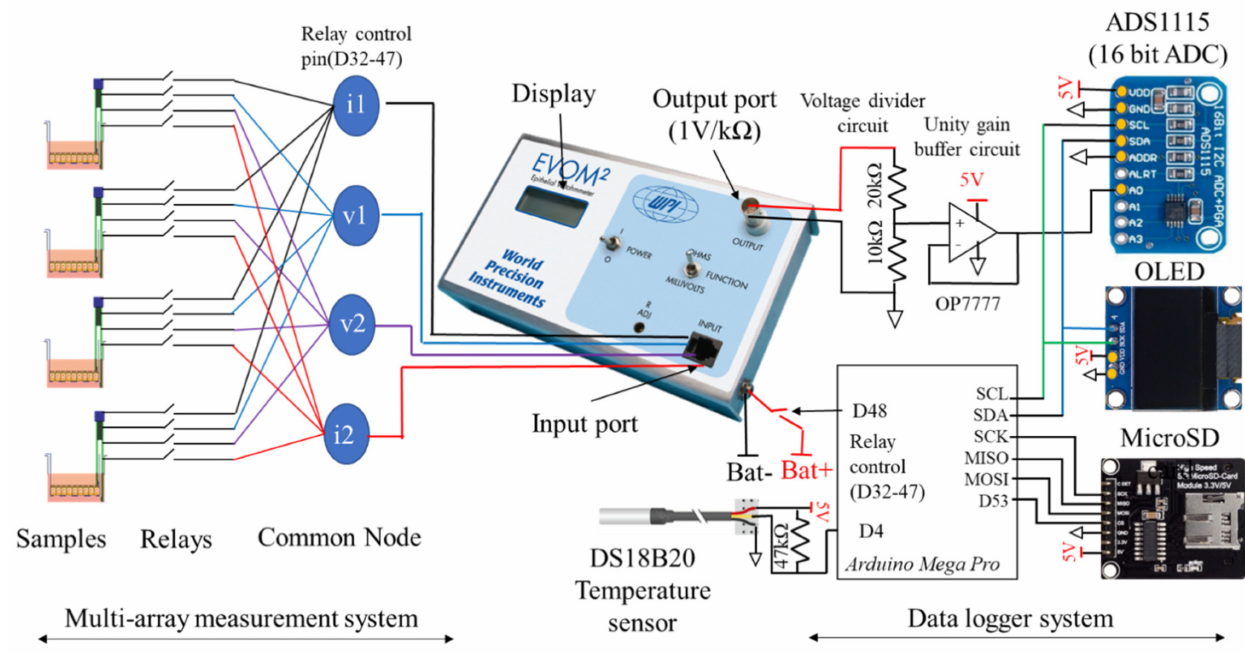
Figure 2. System schematic showing the multi-array measurement and custom data logger system of the proposed EVOM add-on device for real-time TEER measurement in multiple tissue culture transwell samples. Detail schematic is available in Supplementary File